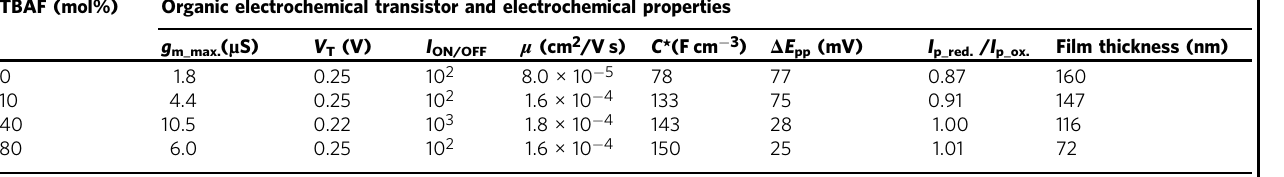
Table 1 A summary of organic electrochemical transistor parameters and electrochemical properties. TBAF (mol%) Organic electrochemical transistor and electrochemical properties